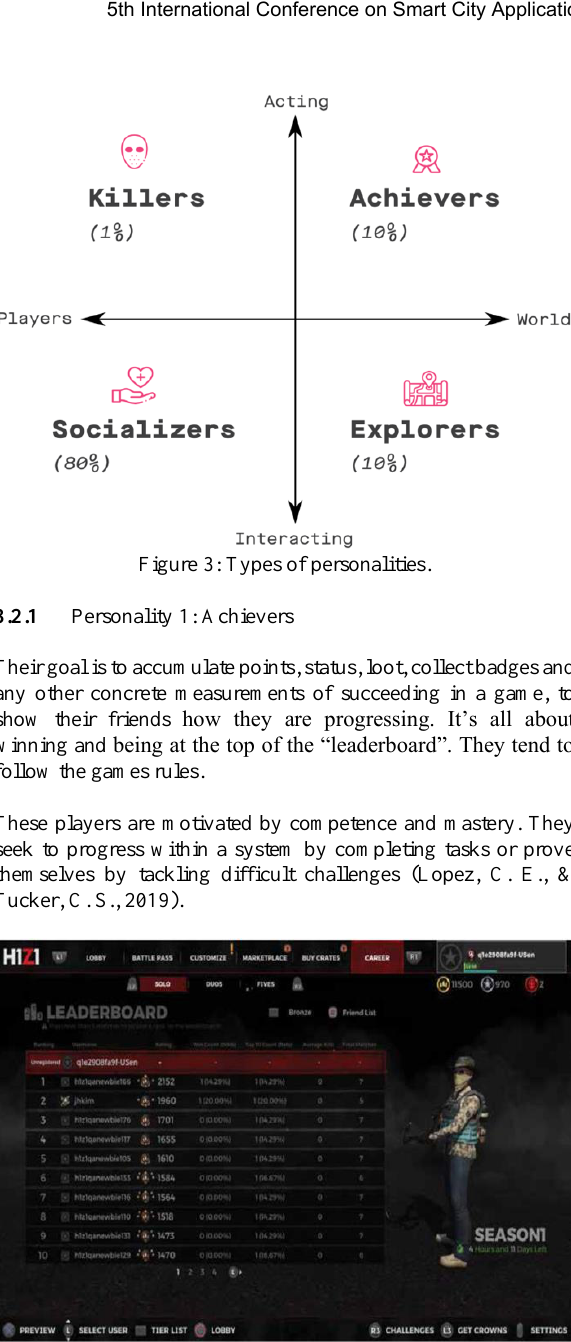
Figure 4: Achievers game example.